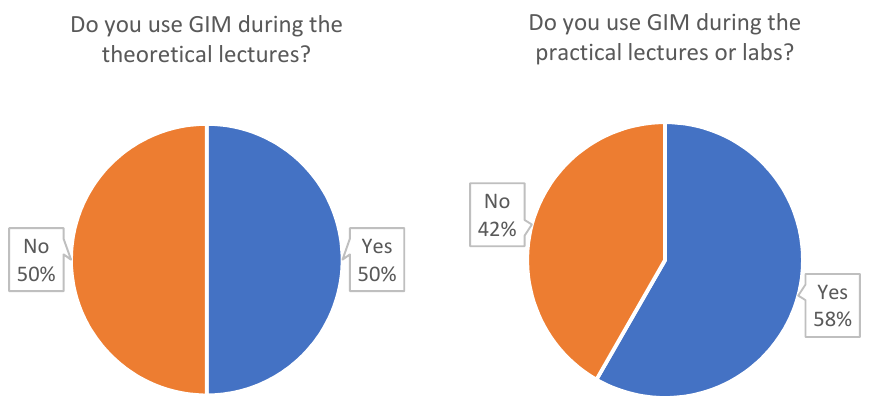
Figure 24. Use of GIM in the teaching process.